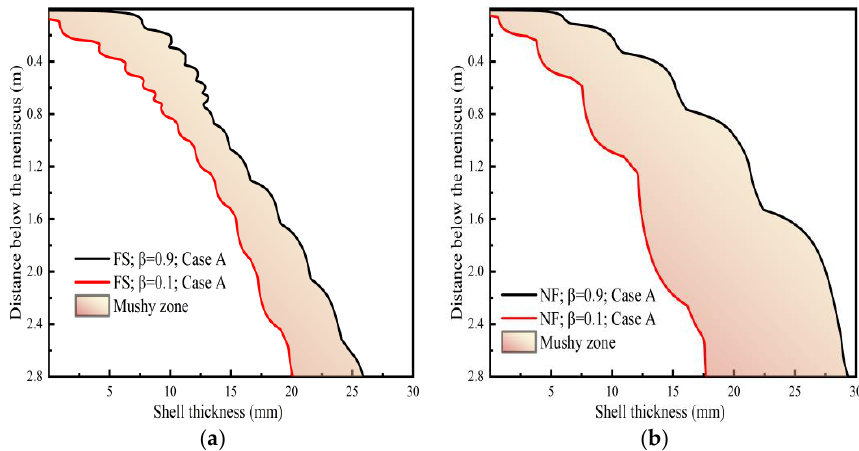
Figure 13. Heat flux profiles and strand surface temperatures as a function of distance from the meniscus. The centerlines of the narrow and wide faces were monitored.